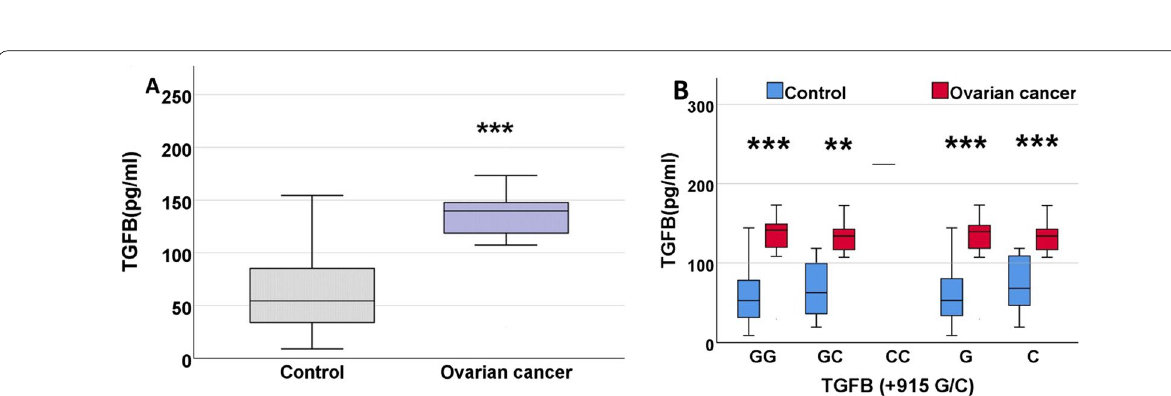
Fig. 3 IL6 concentration (pg/ml) in relation to A control and OC groups, B genotypes and alleles of IL6 ( ovarian cancer groups. Results are expressed as mean